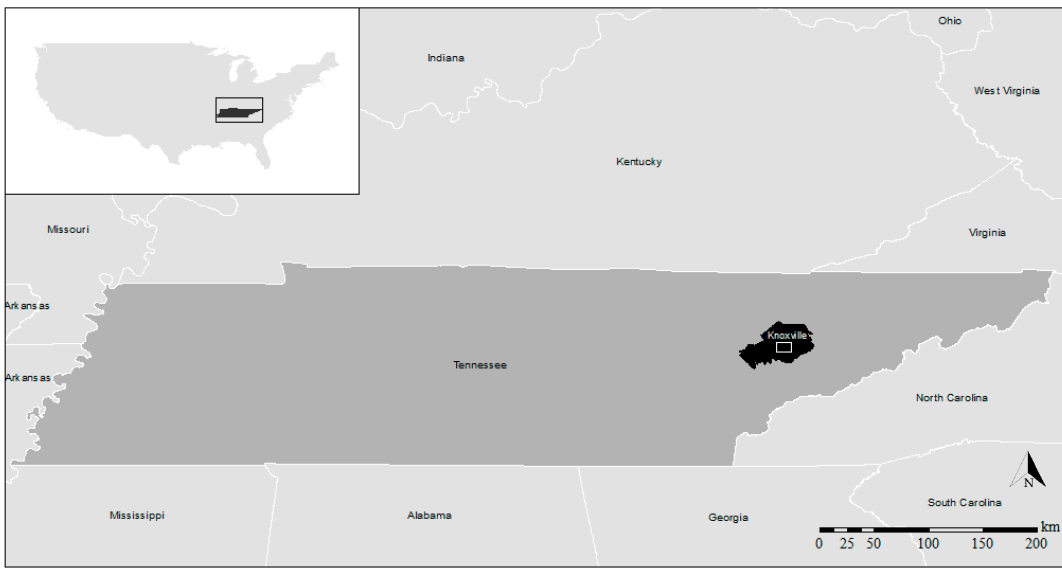
Figure 1. Location of Knoxville, Tennessee, within the United States of America.